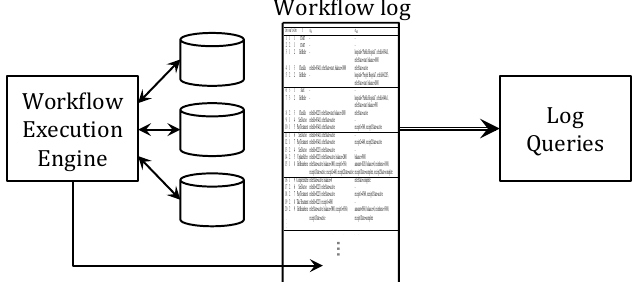
Figure 2. Our framework for flexible process